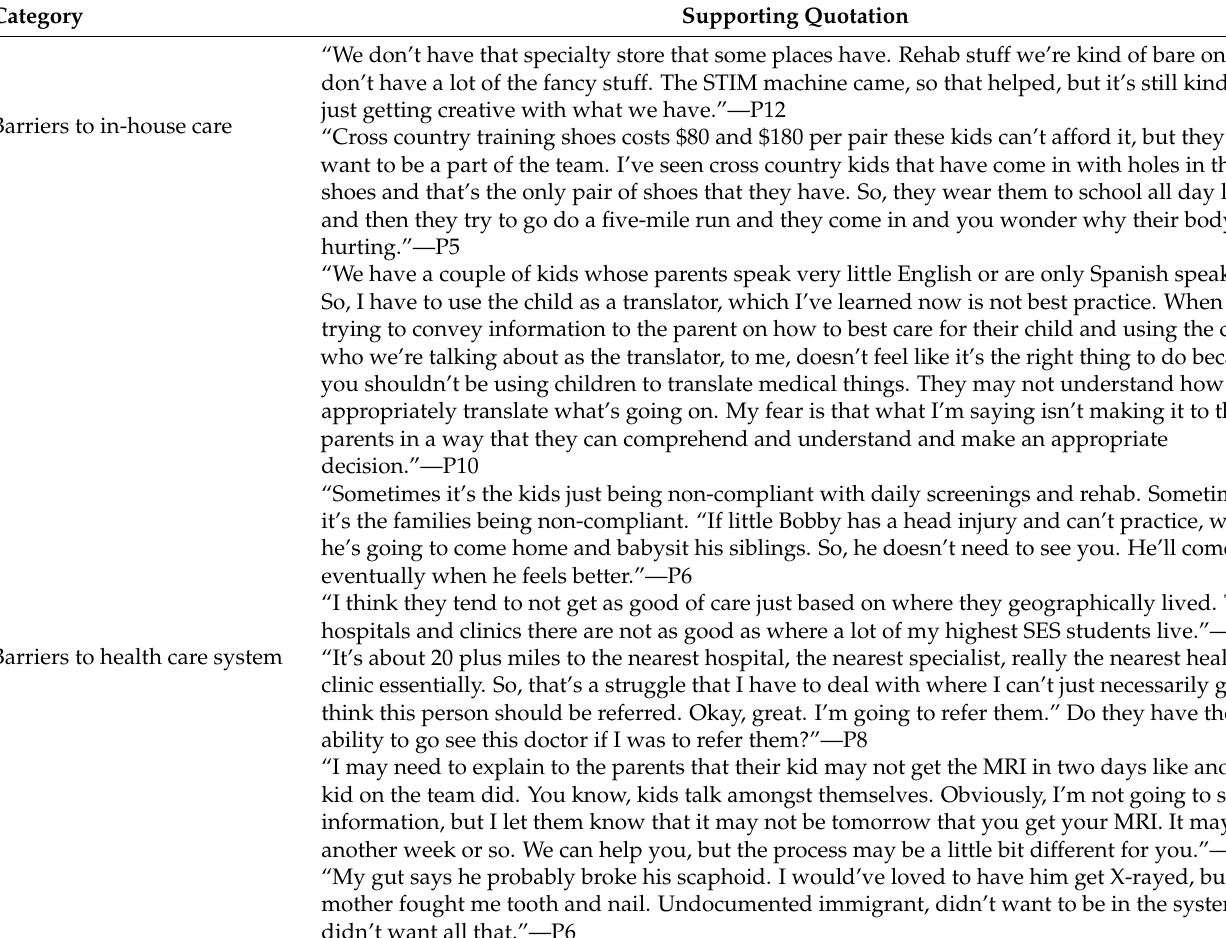
Table 4. Impact of SES on